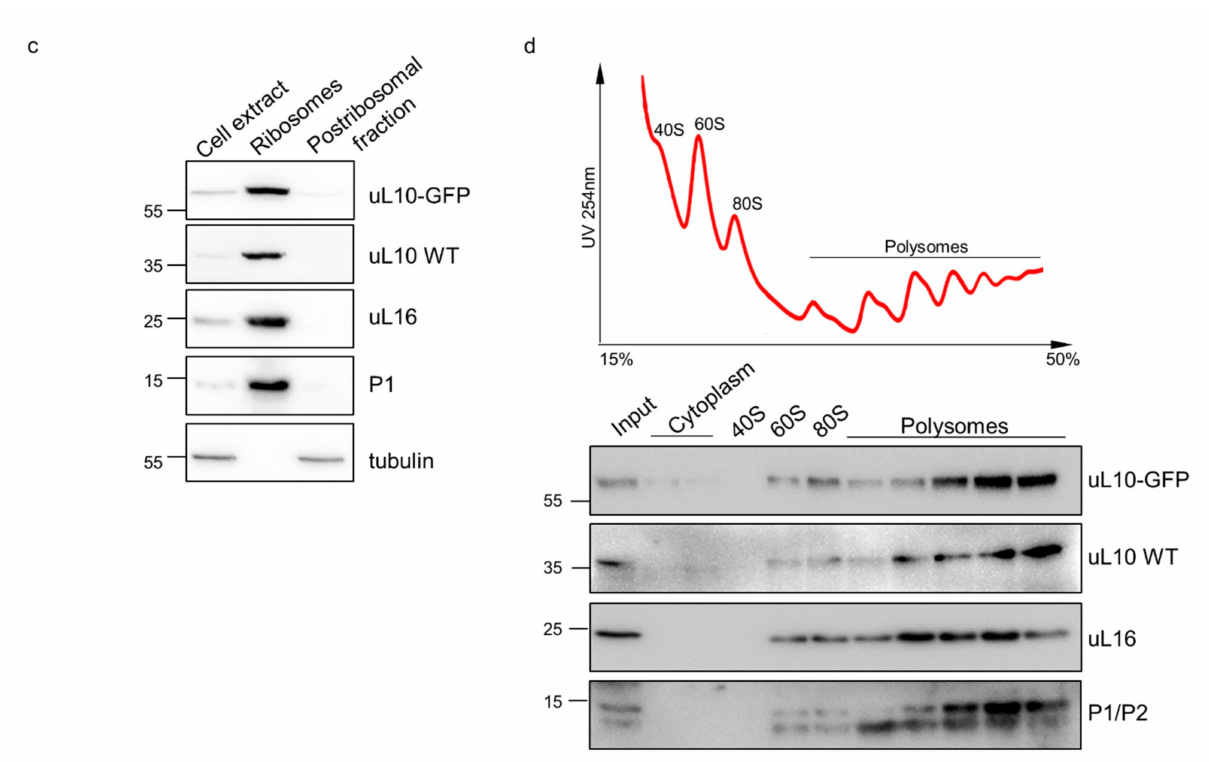
Figure 6. Characterization of Dox regulated expression of uL10-GFP in the double-stable HeLa cell line generated through the ‘fast track’ protocol. ( a ) Dox-dose dependent expression of uL10-GFP in the DS HeLa cell line established with the Tet-On3G-T2A-Puro system. Left panel: Live-cell images of double stable HeLa cells treated with different concentrations of Dox (0, 1, 5, 50 ng/mL). Fluorescence of uL10-GFP is shown on the left, the contrast phase view of the cells is shown in the middle panel, and merged images are presented on the right, scale bar 20 µ m. Right panel : Immunodetection of uL10-GFP protein expression in response to different concentrations of Dox. Double stable HeLa cells were treated with increasing concentrations of Dox (0, 1, 5, 50 ng/mL) for dose-dependent induction of uL10-GFP, lysed and analyzed by Western blotting using anti-GFP antibodies. Antibodies against GAPDH were used as a loading control. Full-length blots are presented in Supplementary Figure S6a. ( b ) Fluorescence intensity profiles and live-cell images of DS HeLa cells after prolonged cryopreservation and cultivation upon Dox induction (+Dox) and without Dox (-Dox). Red arrows indicate the analyzed cells and correspond to the distance axis within the fluorescence intensity plots. Scale bar 20 µ m. ( c ) Immunodetection of uL10-GFP and specified ribosomal proteins in post-nuclear cell extract, ribosomal (80S) and post-ribosomal (cytoplasmic) fractions of Dox-induced DS HeLa cells after prolonged storage and cultivation. Cells expressing uL10-GFP were fractionated and analyzed by Western blotting using anti-GFP antibodies and antibodies recognizing particular native ribosomal proteins: uL10, uL16, and P1. Antibodies against tubulin were used to show the purity of fractions. Full-length blots are presented in Supplementary Figure S6b. ( d ) Polysome profile of whole-cell polysomal extracts prepared from the Dox-induced DS HeLa cell line after prolonged storage and cultivation ( upper panel ) followed by Western blotting of polysomal fractions analyzed with antibodies against GFP and native ribosomal proteins: uL10, uL16, and P1 ( bottom panel ). Full-length blots are presented in Supplementary Figure